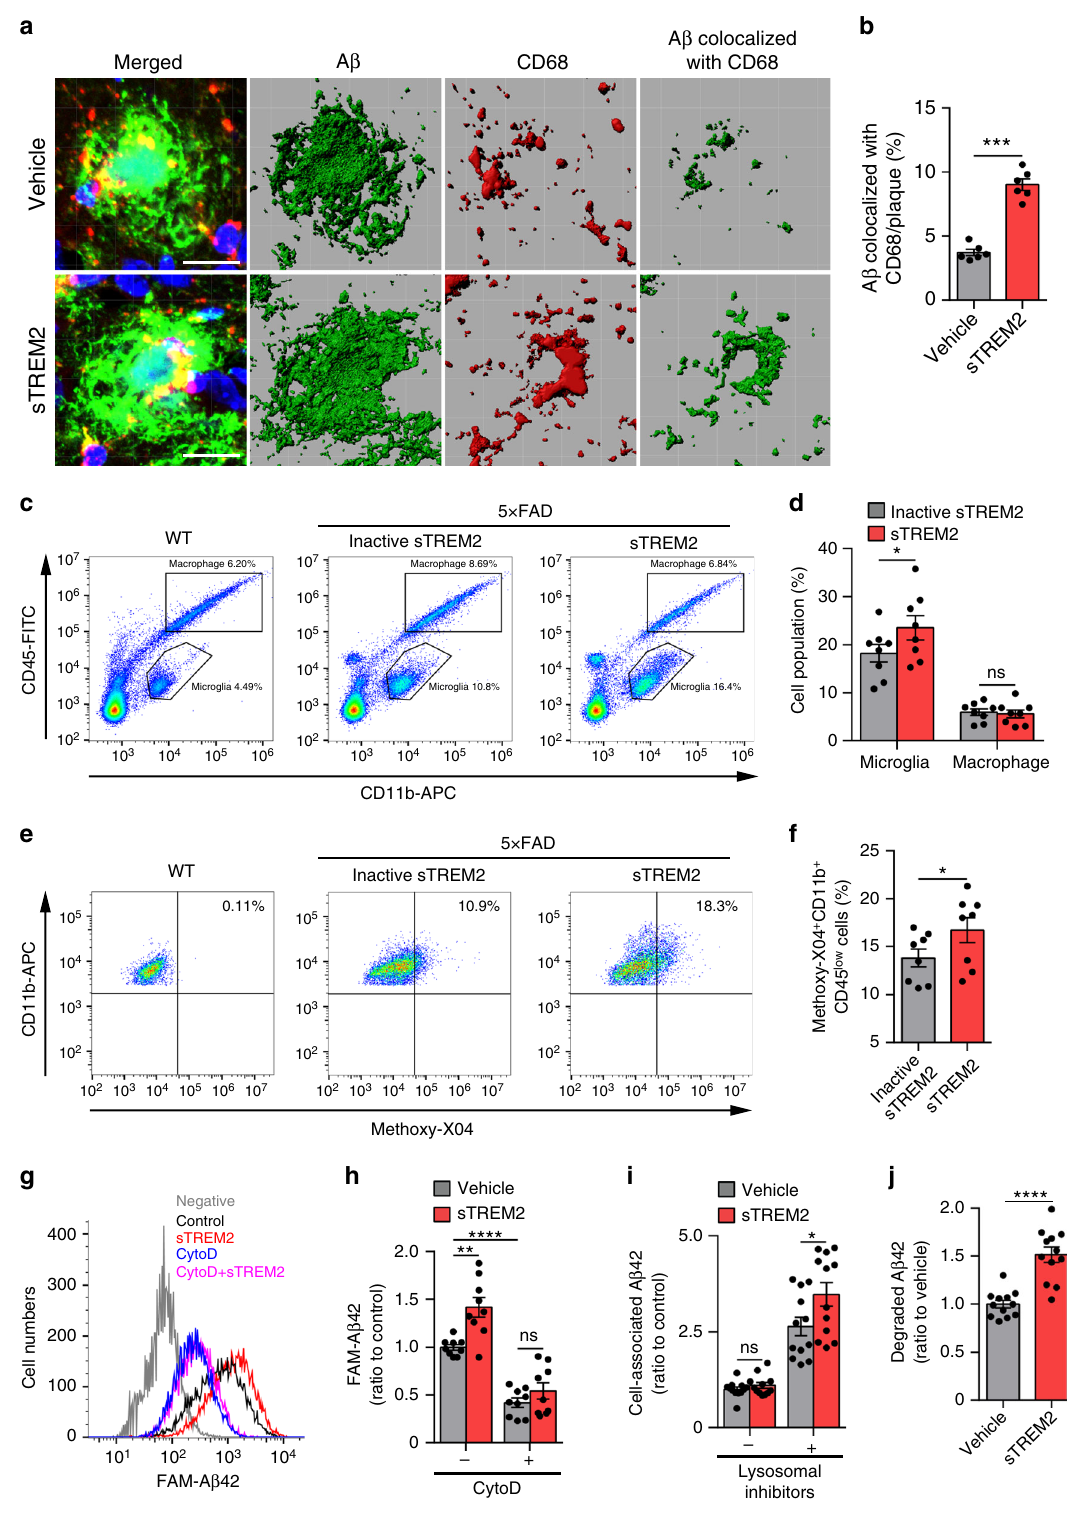
(mEPSCs) and miniature inhibitory postsynaptic currents (mIPSCs). The amplitude and frequency of both mEPSCs and mIPSCs did not signi fi cantly differ between Fc- and sTREM-Fc- treated groups (Supplementary Fig. 4h – k). Furthermore, sTREM2 did not affect the abundance of synaptic proteins in the primary neuronal cultures (Supplementary Fig. 4l, m), suggesting that sTREM2 does not directly modulate synaptic plasticity and